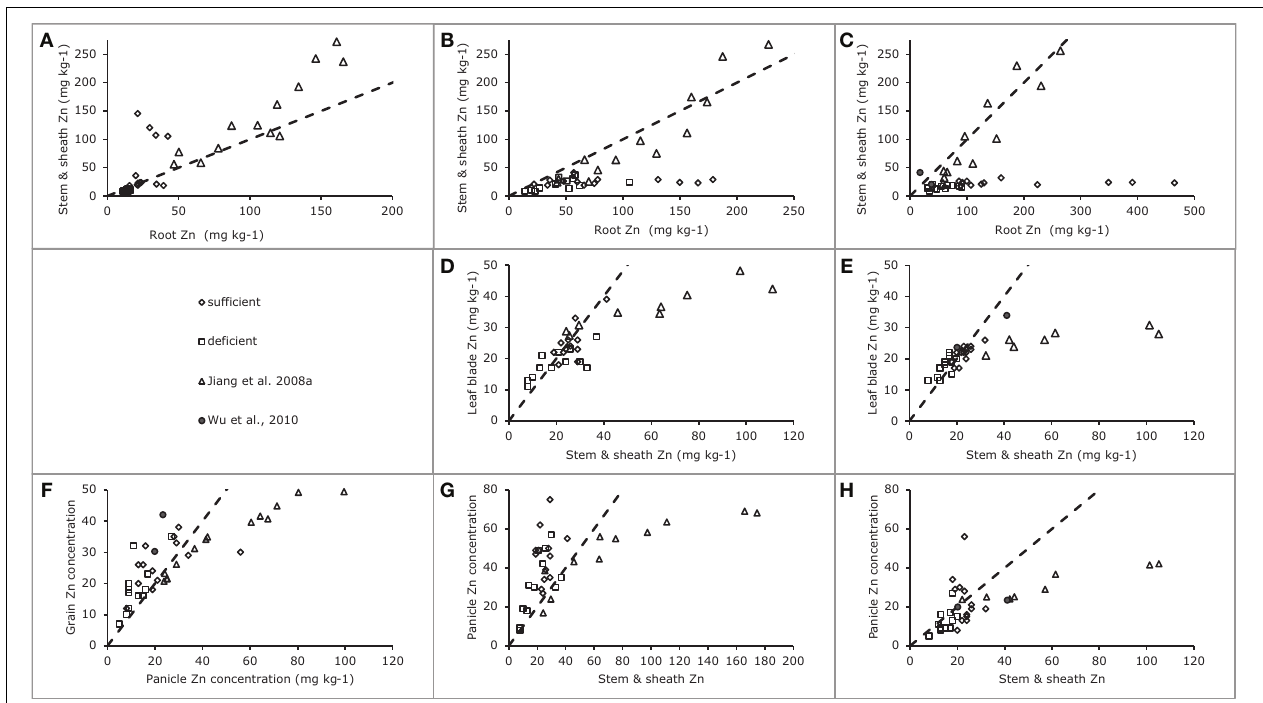
FIGURE 5 | Zinc concentrations in generative plant tissues as indicated along the axes for data from Impa et al. (2013), Wu et al. (2010) and Experiment 4 [see also Jiang et al. (2008a)]. Panel (A) for plants harvested during the early vegetative stage, Panels (B) , (D) , and (G) for plants harvested at flowering and Panels (C) , (E) , (F) , and (H) for plants harvested at grain maturity. Data points from Impa et al. (2013) represent averages per